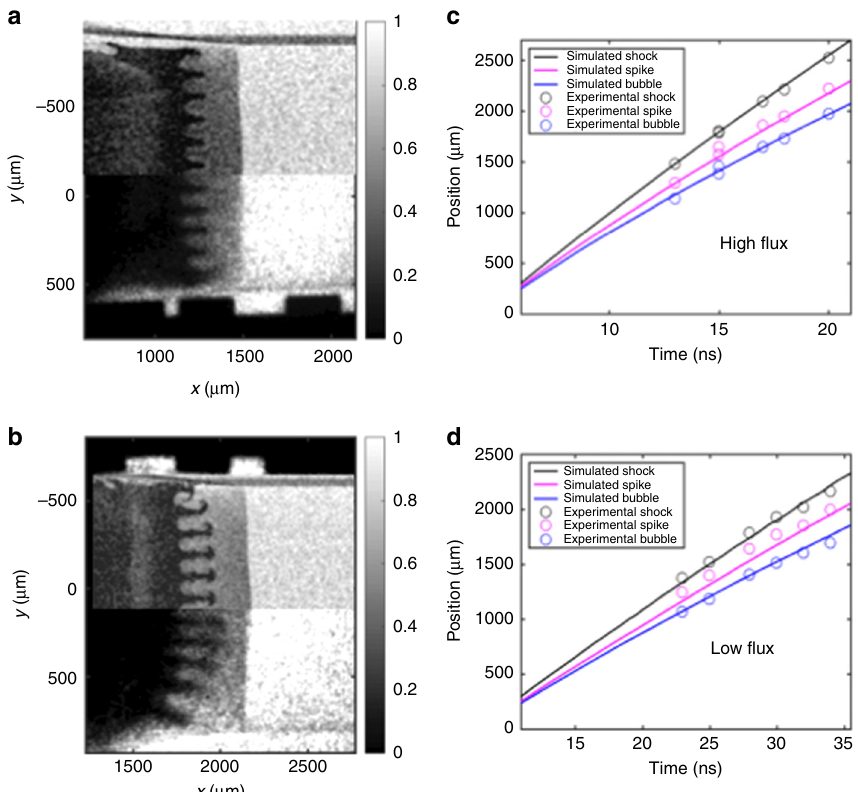
Fig. 2 Experimental data and results of simulations. In order for the simulation results to reproduce the shock positions, the energy fl ux driving the dense plastic was reduced to 78% of its nominal value. The simulated and observed radiographs are shown for a the high- fl ux and b the low- fl ux cases. The simulated radiographs are post-processed results from CRASH simulations. c and d show the feature position vs time for the high- fl ux and low- fl ux cases, respectively. Shock, spike, and bubble positions for the simulation results are shown with solid lines and the experimental data points have an error roughly the size of the data point. The simulations were performed in Cartesian ( x – y )